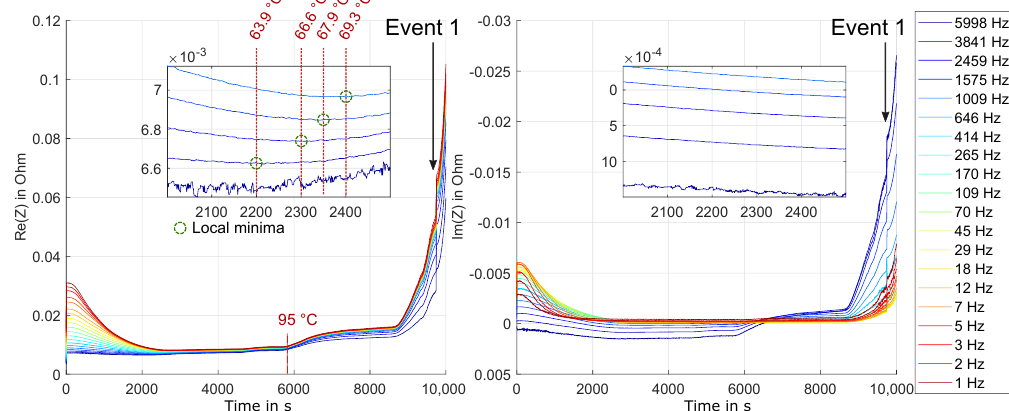
Figure 12. Experiment HT2: Real and imaginary parts of the impedance over the first 10,000 s of the experiment. In the zoomed in area, the trend change of the real part is shown for frequencies between 1kHz–6kHz. In the same temperature range, the imaginary part does not show any distinct